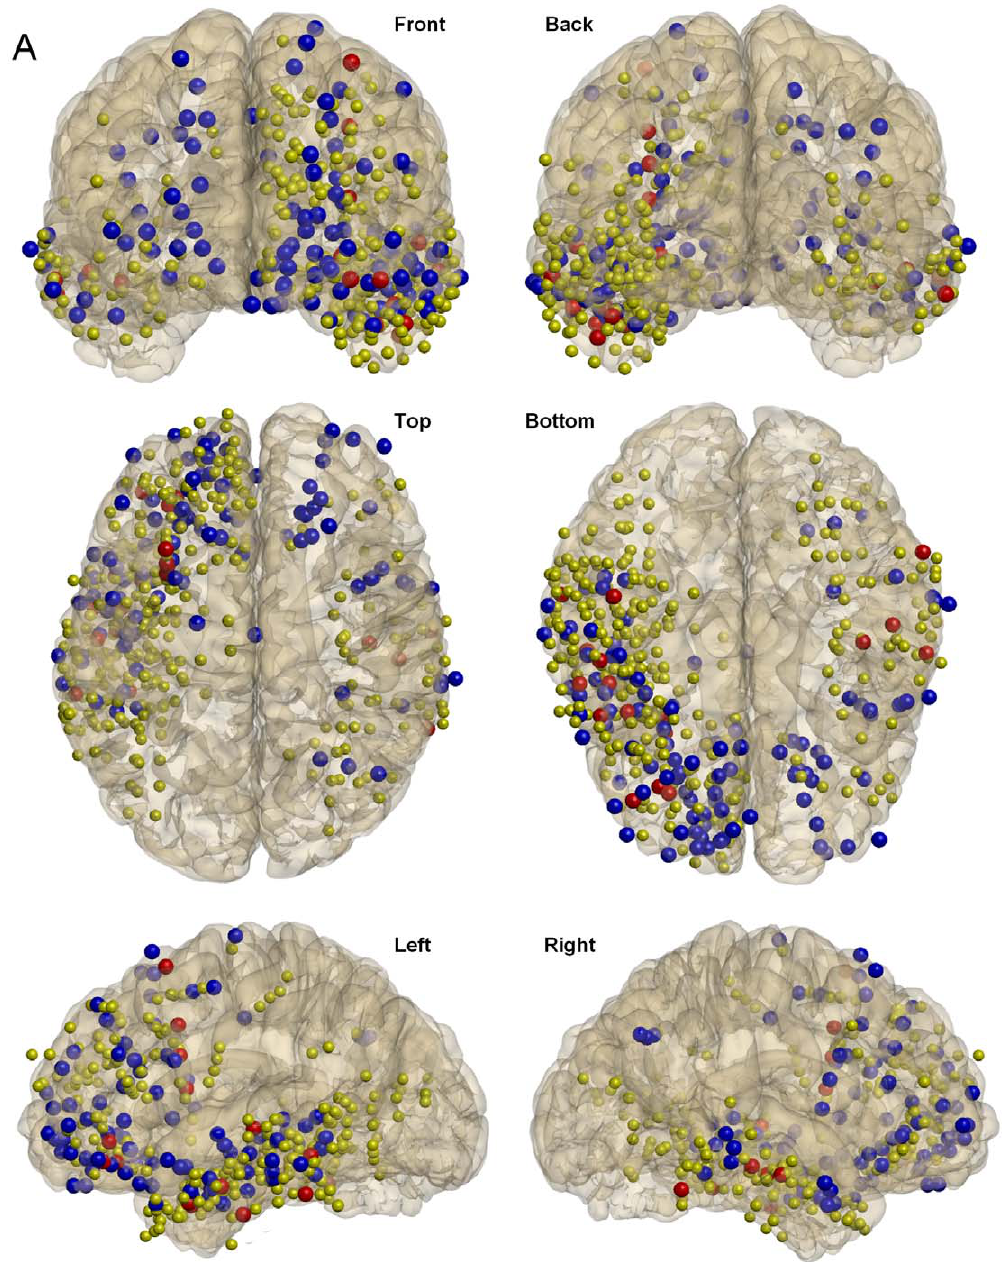
Figure 6. Spatial distribution of phase-modulated gamma patterns. Locations of all intracranial contacts associated with IN-phase ( blue balls ) and ANTI-phase ( red balls ) patterns for 11 subjects for which Talairach coordinates could be successfully estimated are superimposed on a cortical reconstruction of one subject. Yellow balls correspond to the locations of all analyzed contacts for the corresponding 11 subjects (418). From left to right and from top to bottom, views are presented from the following planes: frontal-coronal, back-coronal, top-axial, bottom-axial, left-sagital and right-sagital.